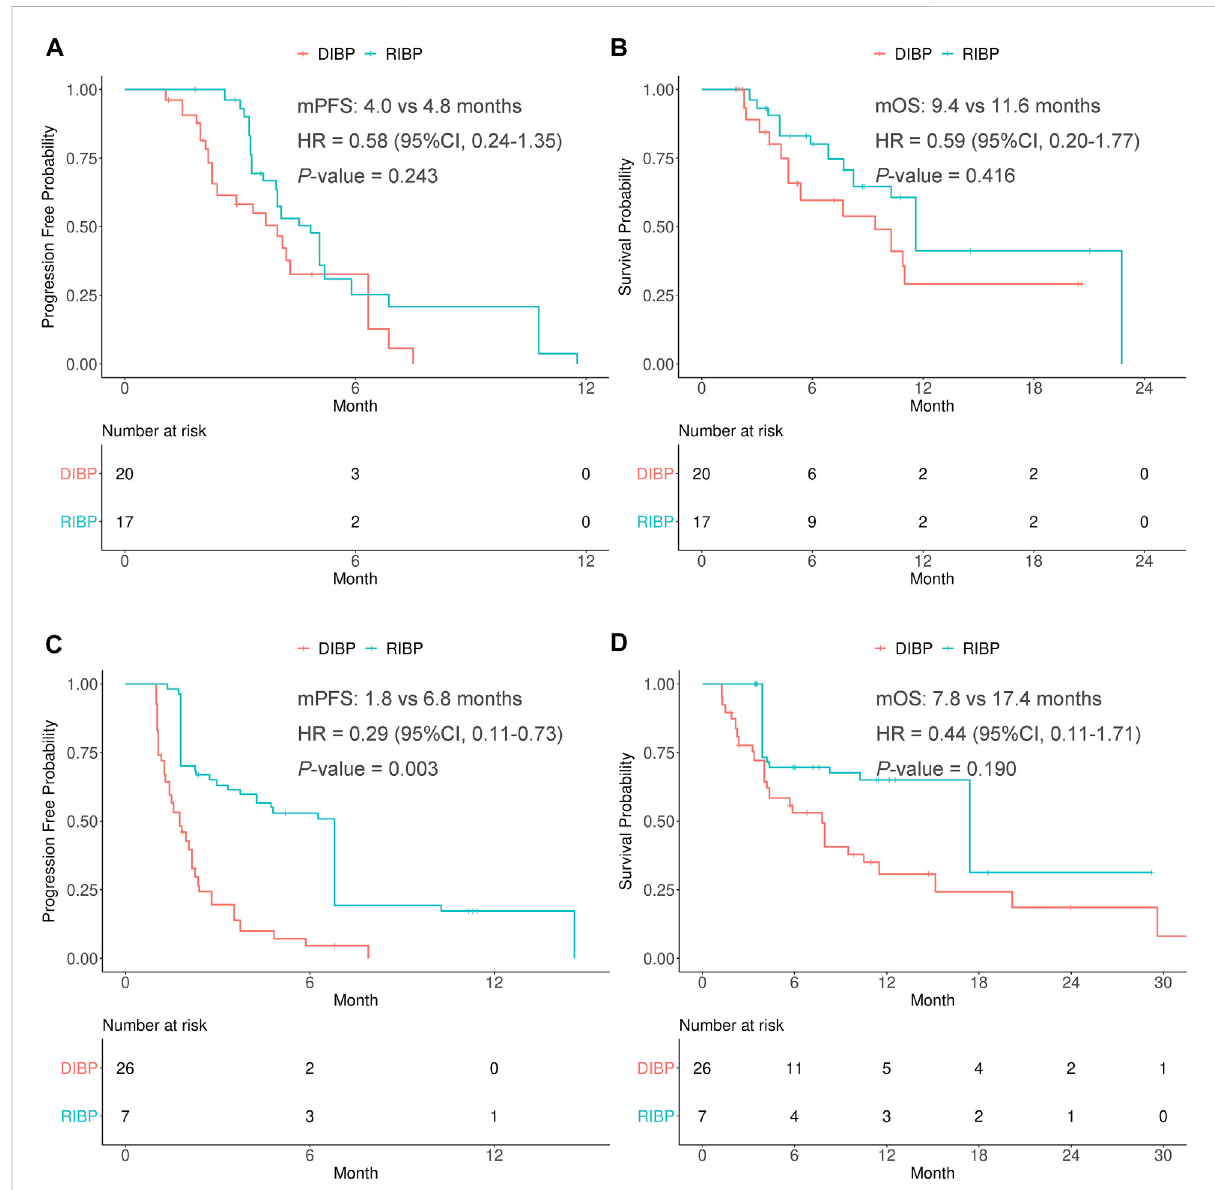
FIGURE 3 Kaplan-MeiercurvesofPFS (A,C) andOS (B,D) fromweighteddatainthePRresponseandSD/PDresponsetoinitialimmunotherapysubgroups. RIBP, rechallenge of immunotherapy beyond progression; DIBP, discontinuation of immunotherapy beyond progression; mPFS, median progression-free survival; mOS, median overall survival; HR, hazard ratio; CI, con fi dence